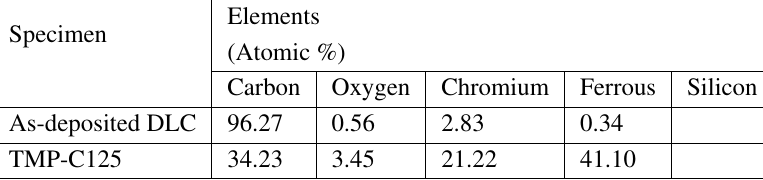
Table 3. EDS analysis of a-C:H coating at various